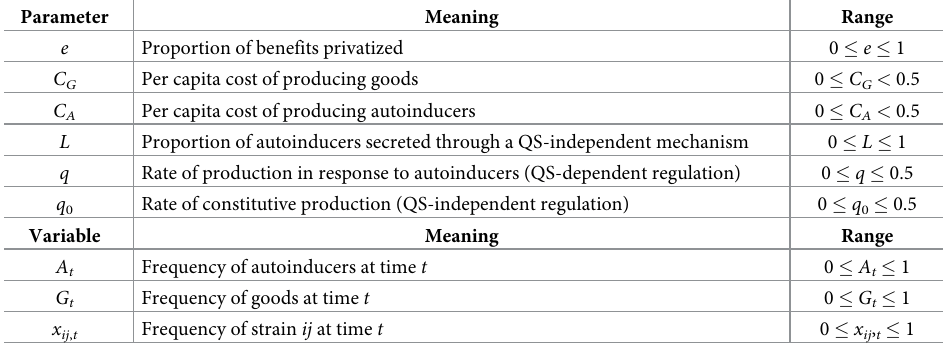
Table 2. List of parameters and variables and their meaning and range.